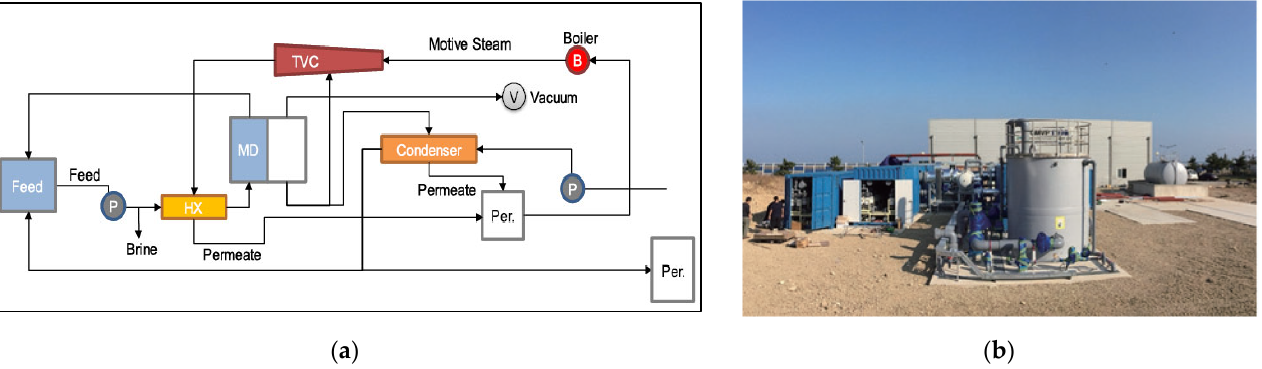
Figure 7. ( a ) Schematic diagram of membrane distillation (MD) desalination system, ( b ) MD desalination pilot plant with a water production capacity of 400 m 3 /day [52,54] .